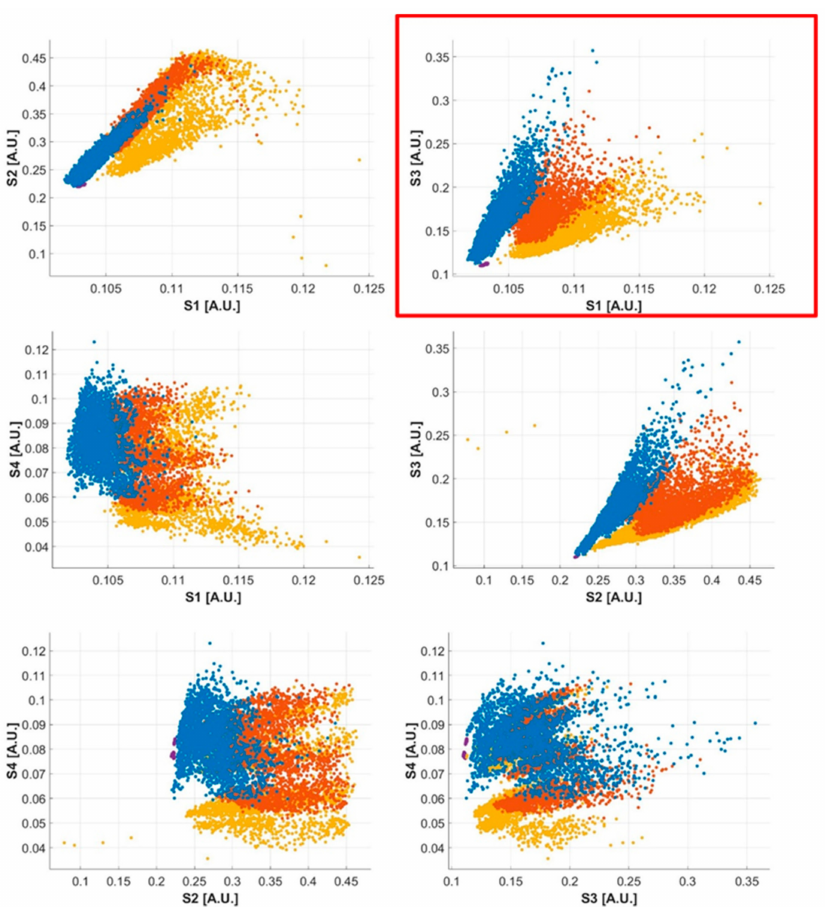
Figure 10. Clusters of points for all the possible combinations of sensor couples: S1–S2, S1–S3, S1–S4, S2–S3, S2–S4, and S3–S4. The S1–S3 couple produced well-defined clusters of points for the four investigated conditions. Lower section (blue), middle section (orange), upper section (yellow), and bow raised (violet).